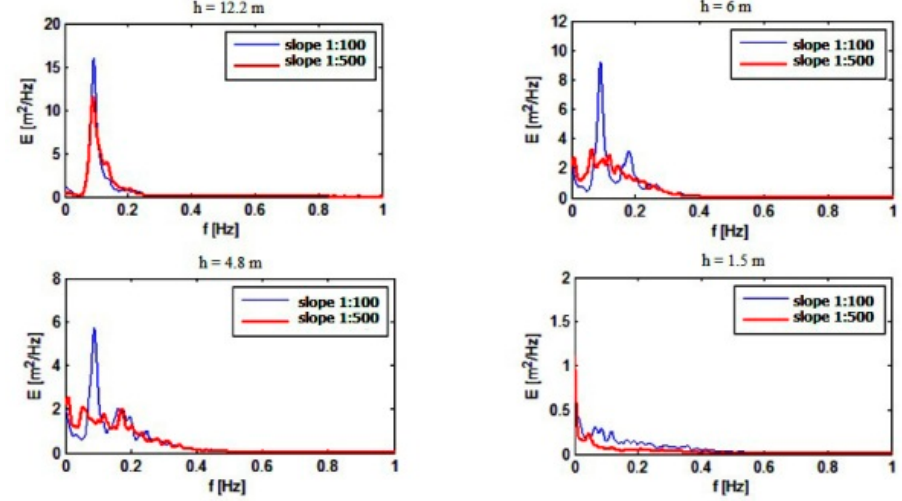
Figure 7. Wave spectra calculated by SWASH over the distance for a steeper slope 1:100 (blue thin line) and a very gentle slope 1:500 (red thick line), at several equal water depths (note the varying vertical scaling).